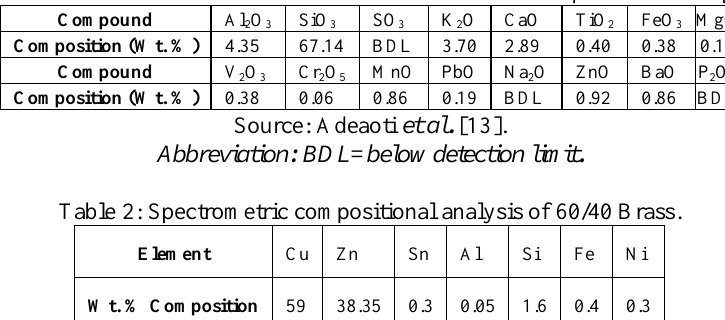
Table 1: Chemical characterization of Saman-Burkono Graphite head sample.